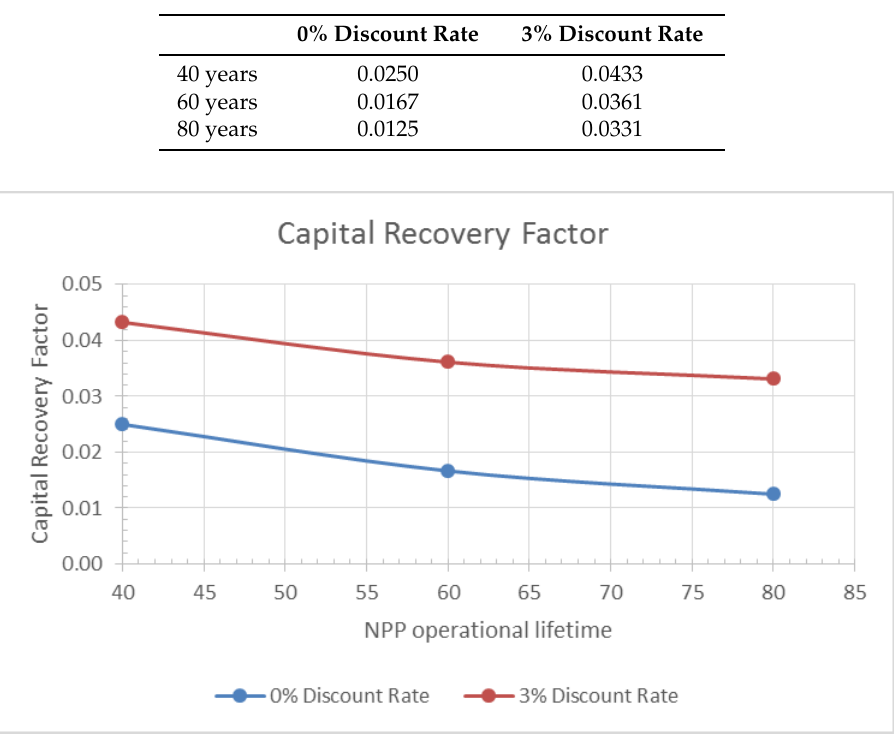
Figure 9. Capital recovery factor.